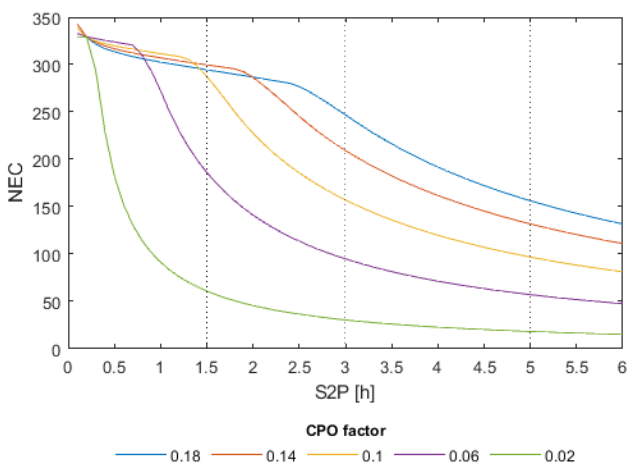
Figure 10. Number of equivalent cycles factor for the annual constant power setpoint (ACPS).